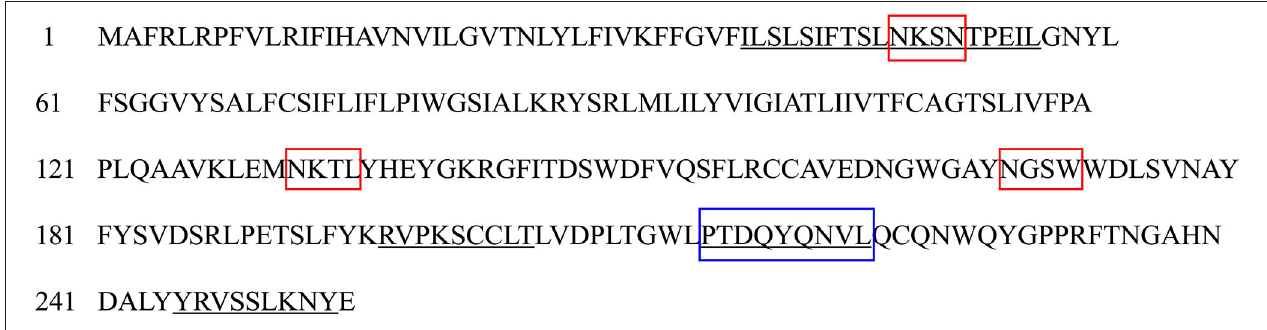
FIGURE 1 | The deduced amino acids sequence of TSP11. Underlined: five protein kinase phosphorylation sites; border marked on frame: three potential N-terminal glycosylation sites; shaded: one tyrosine kinase phosphorylation site.